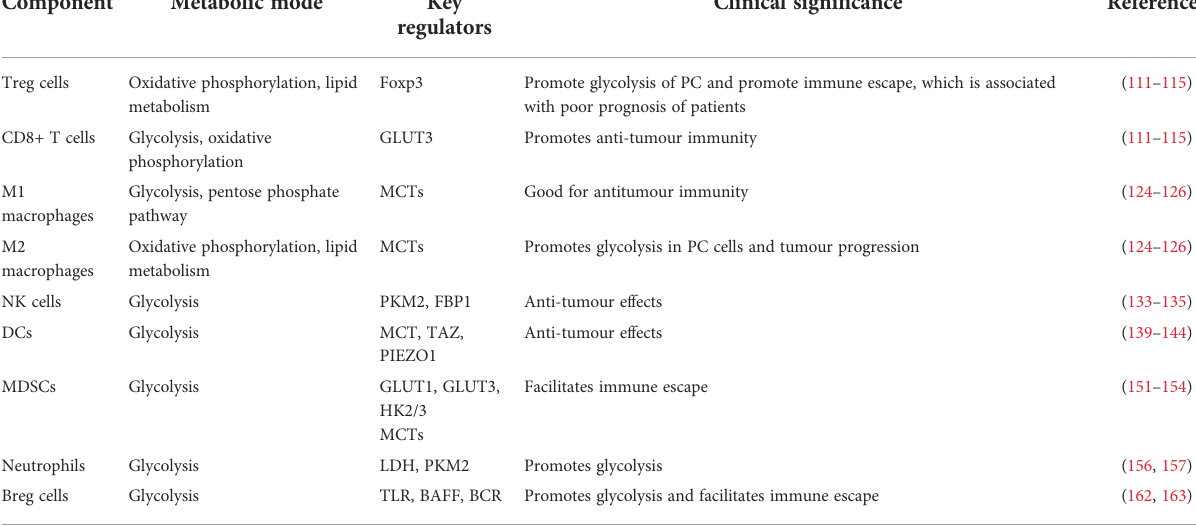
TABLE 2 Immune cell metabolism patterns in the TME and their effects on